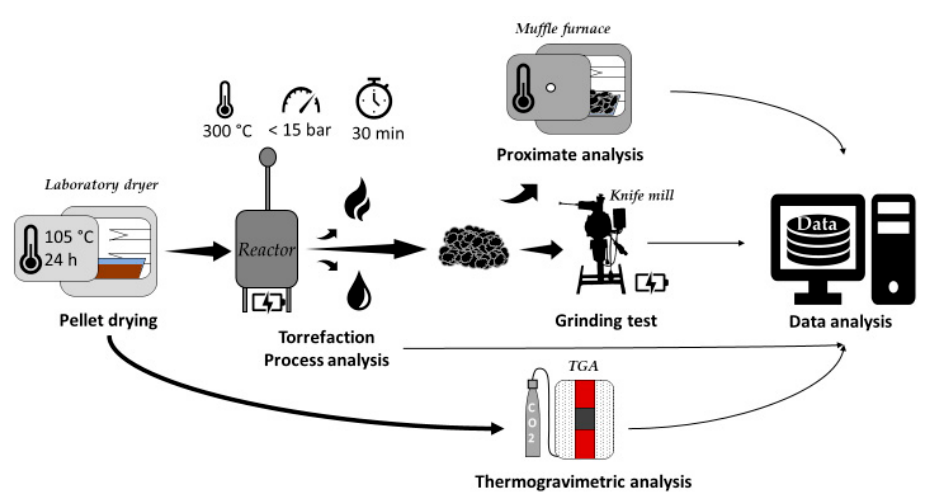
Figure 1. Experiment setup to determine fuel properties of torrefied pellets produced at atmospheric and high-pressure conditions.